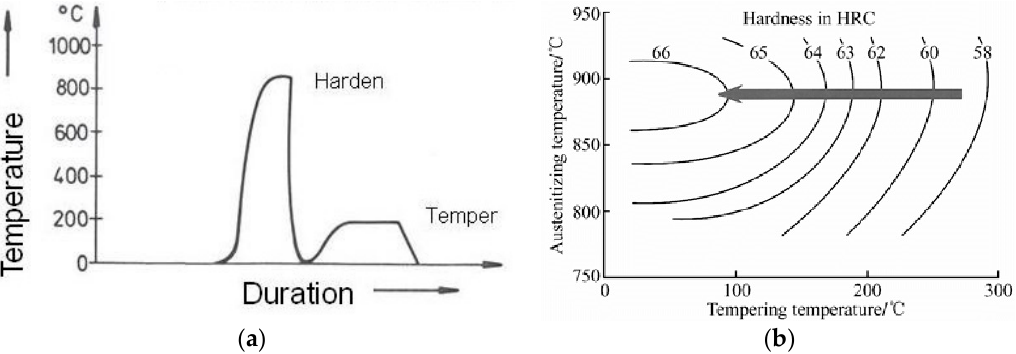
Figure 14. Relation between tempering temperature and hardness ( a ) Martensitic through hardening treatment; ( b ) tempering temperature vs hardness [50]. treatment; ( b ) tempering temperature vs hardness [50].